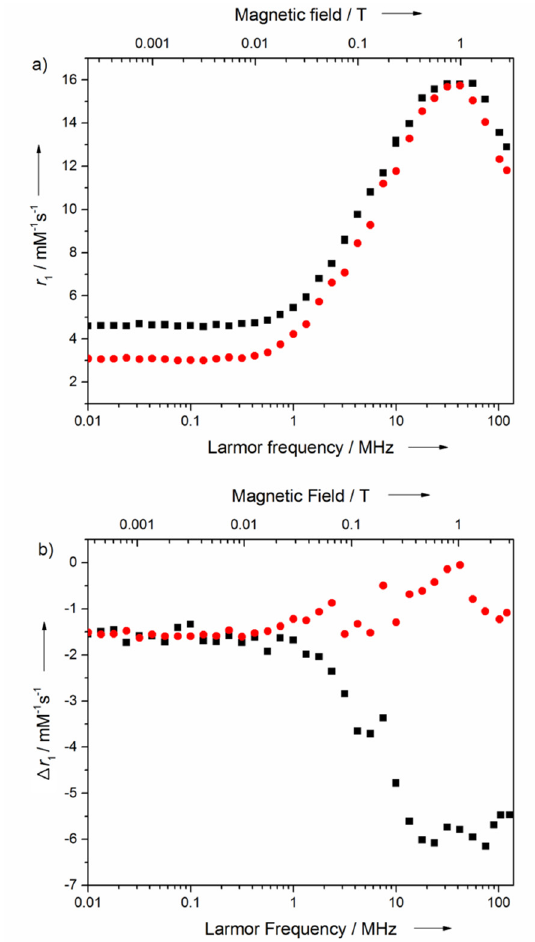
Figure 2. The nuclear magnetic relaxation dispersion (NMRD) profiles of Gd-DTPA ( ), MnTPPS ( ), m -MnP2 ( ), and MnP2( ) in 25 mM pH 7.2 HEPES buffer from 0.23 mT to 3 T at 25 °C. MnP r 1 was normalized to per Mn(III) ion.